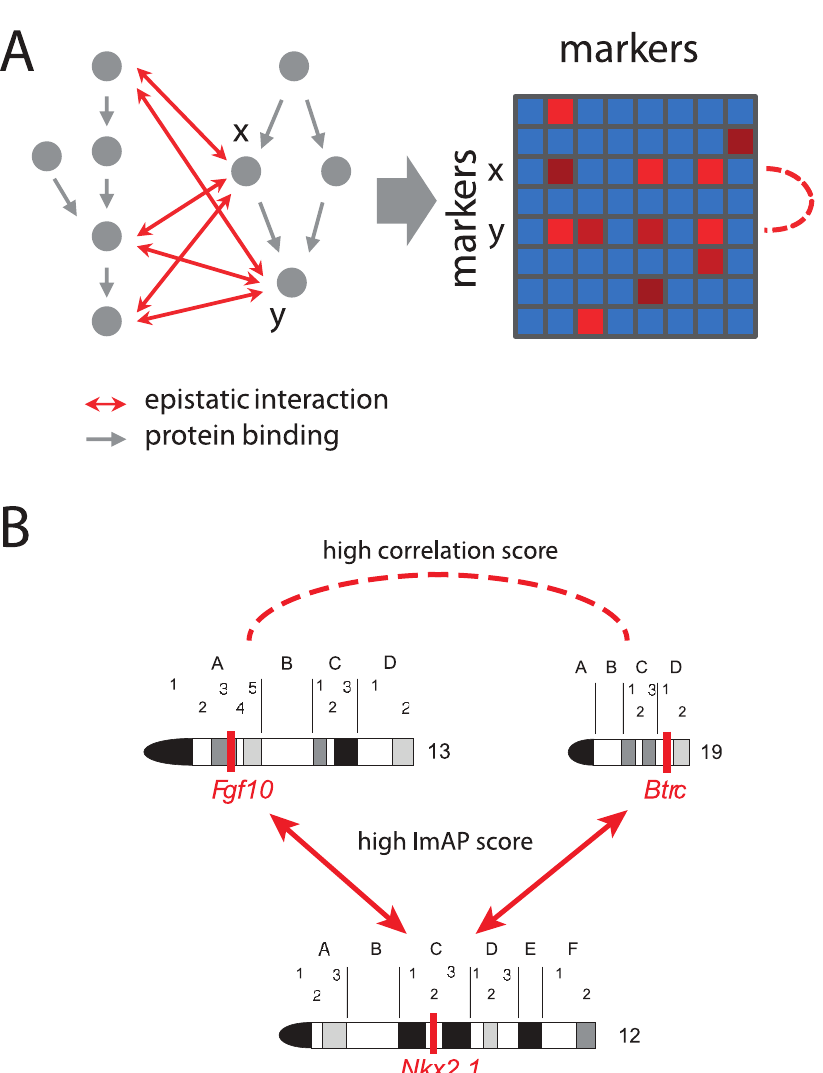
Figure 5. Correlated interaction profiles. (A) Schematic showing relationship between epistatic interactions and molecular pathways. The genes x and y share three allele incompatibilities with genes from a parallel pathway. In the schematic interaction matrix on the right these shared interactions lead to correlated interaction profiles (rows are correlated; dashed line). (B) Example of two loci on chromosomes 13 and 19 sharing a common interacting locus on chromosome 12 . The position of the loci on the chromosomes is indicated by red bars. The putatively causal genes are written below the loci. Arrows indicate interactions with ImAP p-values v 0 : 0005 , the dashed line indicates a high congruence score ( w 2 ).